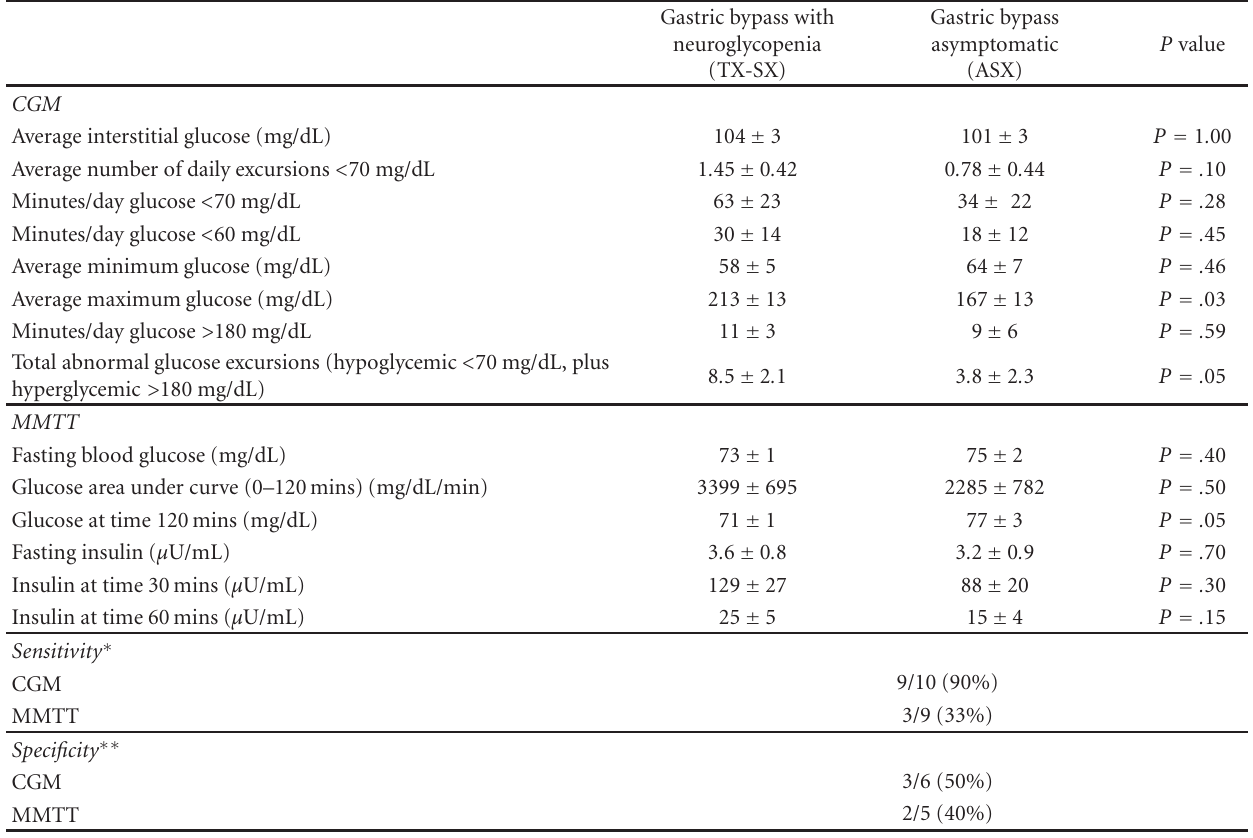
Table 2: Results from continuous glucose monitoring and mixed meal tolerance testing on post-gastric bypass subjects with documented episodes of neuroglycopenia on medical treatment (TX-SX) or without any symptoms of hypoglycemia (ASX).